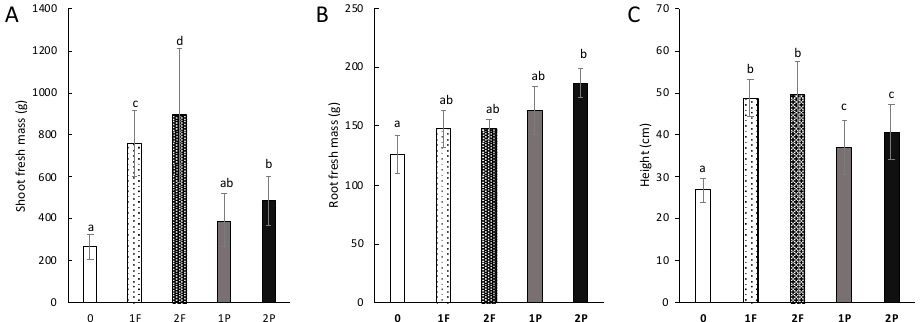
Figure 5. Impact of di ff erent field amendments on celery morphological traits. ( A ) The fresh mass of the celery aerial parts (g); ( B ) the fresh mass of the celery root systems (g); ( C ) the height of the celery aerial parts (cm). Unamended (0), one fertilizer application (1F), two fertilizer applications (2F), one procyanidin application (1P), and two procyanidin applications (2P). n = 30 for aerial parts and n = 6 for roots. Vertical bars indicate standard errors. Differences in letters (a, b, c and ab) indicate a difference in treatment (Tukey’s test for shoot fresh mass and height; Nemenyi’s test for root fresh mass; α < 0.05).